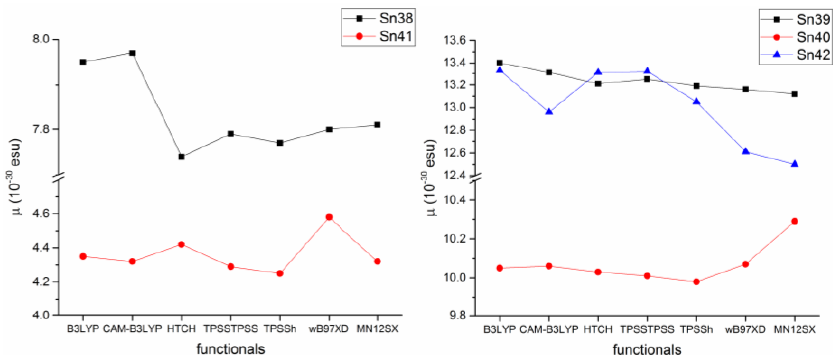
Figure 47. β obtained for the organotin compounds with different functionals.